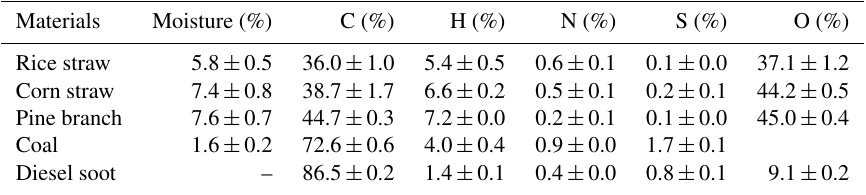
Table 1. Proximate analysis of three biomass materials and two fossil fuels (wt%; n = 4).